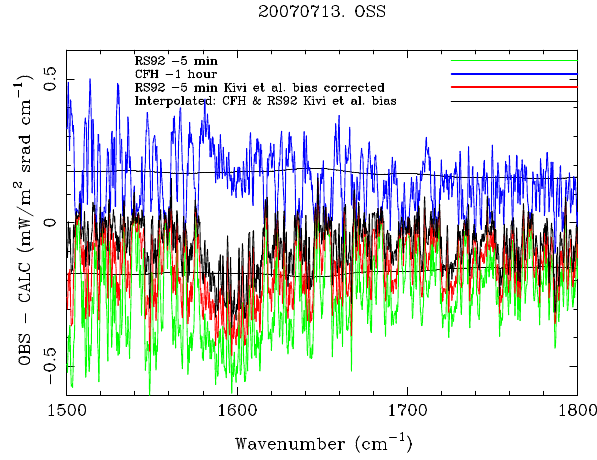
Fig. 7. Residual radiances, IASI observed minus calculated with OSS RTM, for different atmospheric profiles: CFH sonde launched 1h before overpass (blue), RS92 sonde launched 5min before over- pass (green), same sonde but with the Kivi et al. bias correction (red) and the time interpolated profile (black) using CFH (launched 1h before overpass) and Kivi et al. bias corrected RS92 (launched 5min before overpass) measurements. Thin black nearly flat lines correspond to three sigma IASI instrument